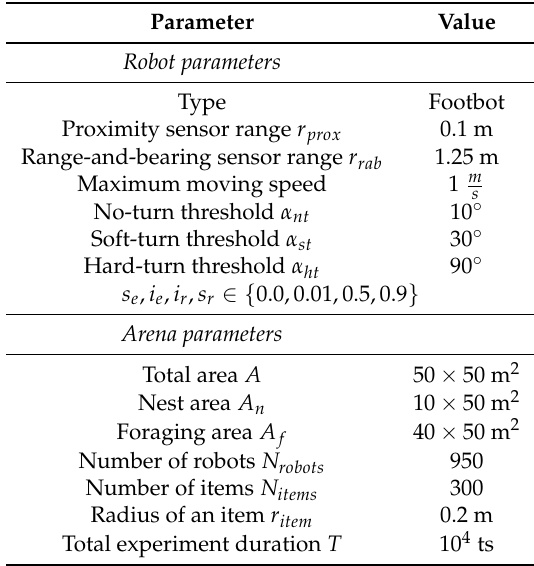
Figure 1. Illustrations of the arena. ( a ) A snapshot from a simulation in ARGoS. Gray area: nest; white area: foraging field; black dots: items; blue objects: Footbots; light-blue lines: communication (range-and-bearing) links. ( b ) 3D view on the same arena. In both figures, the communication links are formed only for resting robots inside the nest, as in our experiments moving robots neither broadcast nor listen to any messages. Table 4. Robot and arena parameters used for the simulation